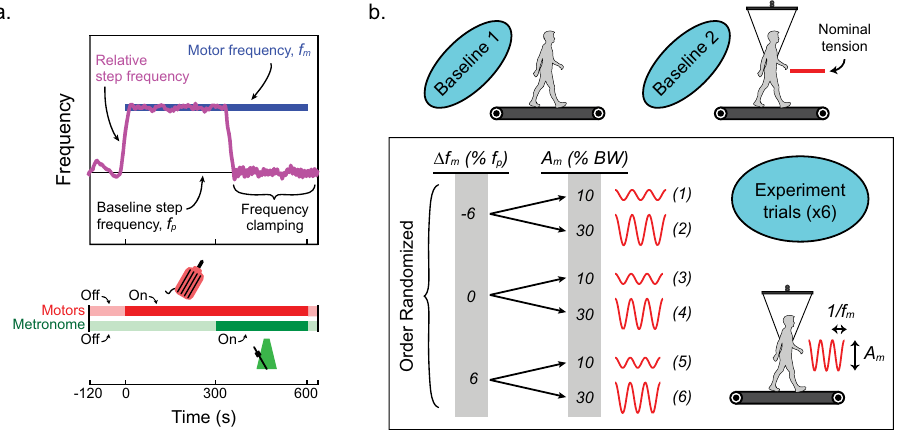
Figure 2. Experimental protocol. ( a ) A generic trial condition is depicted with example step frequency data over time (magenta) and constant motor frequency (blue). Subjects walk with no oscillations during the first 2 min of the test. Motor oscillations begin at time zero and continue for 5 min while subjects freely interact with the system. Oscillations continue for another 5 min, but now a metronome directs individuals to step at their baseline preferred frequency ( f p ) despite the external oscillation frequency (“frequency clamping”). The oscillations and metronome are terminated, and the subject is given fifteen additional seconds to prepare for the end of the trial. ( b ) Baseline conditions and oscillation parameters prescribed to the system during experiment trials are shown: (cid:31) f m is the percent difference in oscillation frequency relative to subjects’ baseline preferred step frequency ( (cid:31) f m = 0, ± 6% ) and A m is the oscillation amplitude expressed in units of subject body weight (BW) ( A m = 10, 30% ). Trial conditions were implemented randomly to reduce ordering